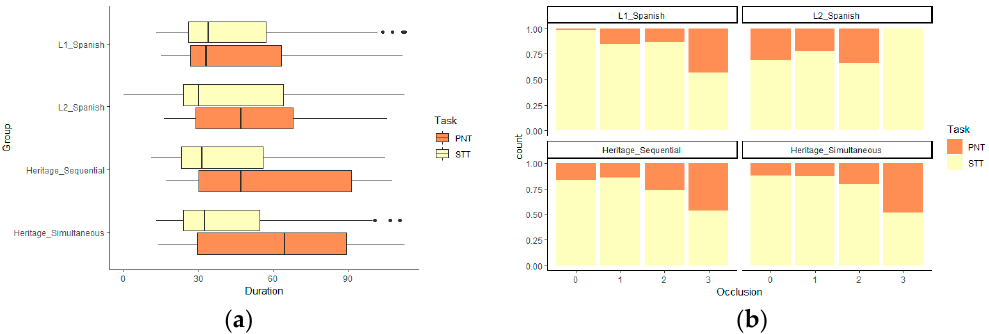
Figure 6. Boxplot for ( a ) rhotic duration according to participant group by task and ( b ) number of apical occlusions according to participant group by task.